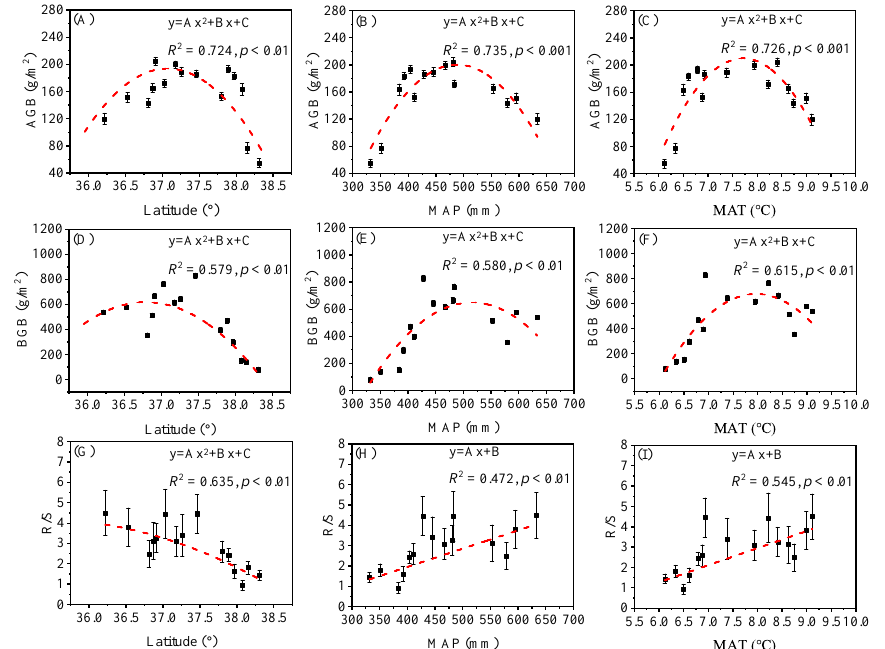
Figure 2. Relationships of AGB, BGB and R/S with MAT, MAP and absolute latitude. Note: ( A – C ), AGB: above-ground biomass; ( D – F ), BGB: below-ground biomass; ( G – I ), R/S: root-to-shoot ratio. The red lines indicate the fits of the linear model of AGB, BGB and R/S and environmental gradient (latitude, MAT and MAP). All climate data (MAT and MAP) was obtained from China Meteorological Data Sharing Service System (http://data.cma.cn/ (accessed on 10 May 2021)).